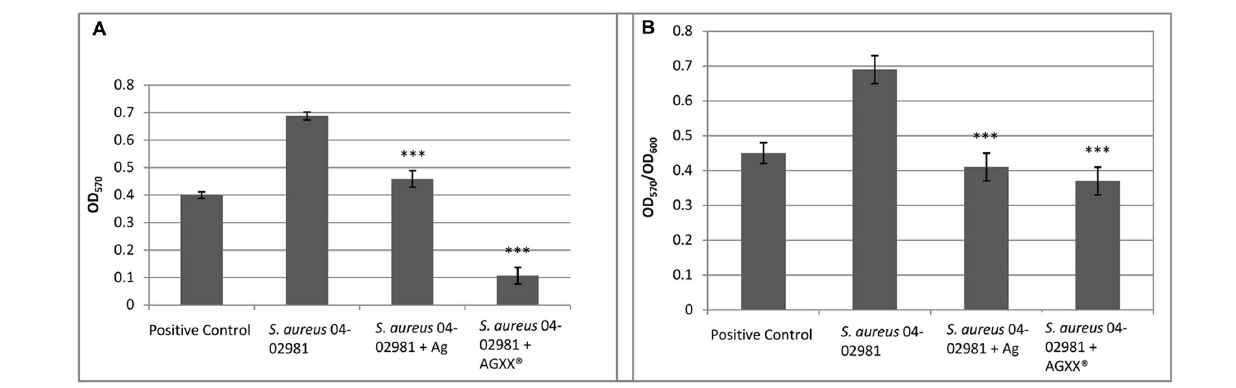
FIGURE 1 | AGXX R (cid:13) reduces biofilm formation of S. aureus 04-02981. Mean of five OD values of the biofilm assay with AGXX R (cid:13) , Ag, and without metal amendment with standard deviation are shown. (A) Shows the biofilm formation by Staphylococcus aureus aureus 04-02981, measured at 570 nm; (B) shows the biofilm formation (OD 570 ) normalized to the bacterial growth (OD 600 ) to take the antimicrobial effect of AGXX R (cid:13) into account. Asterisks indicate the p -values obtained from t -test using SigmaPlot ( ∗∗∗∗ p < 0.0001, ∗∗∗ p < 0.001, ∗∗ p < 0.01, ∗ p < 0.05) representing the statistical significance of the data.